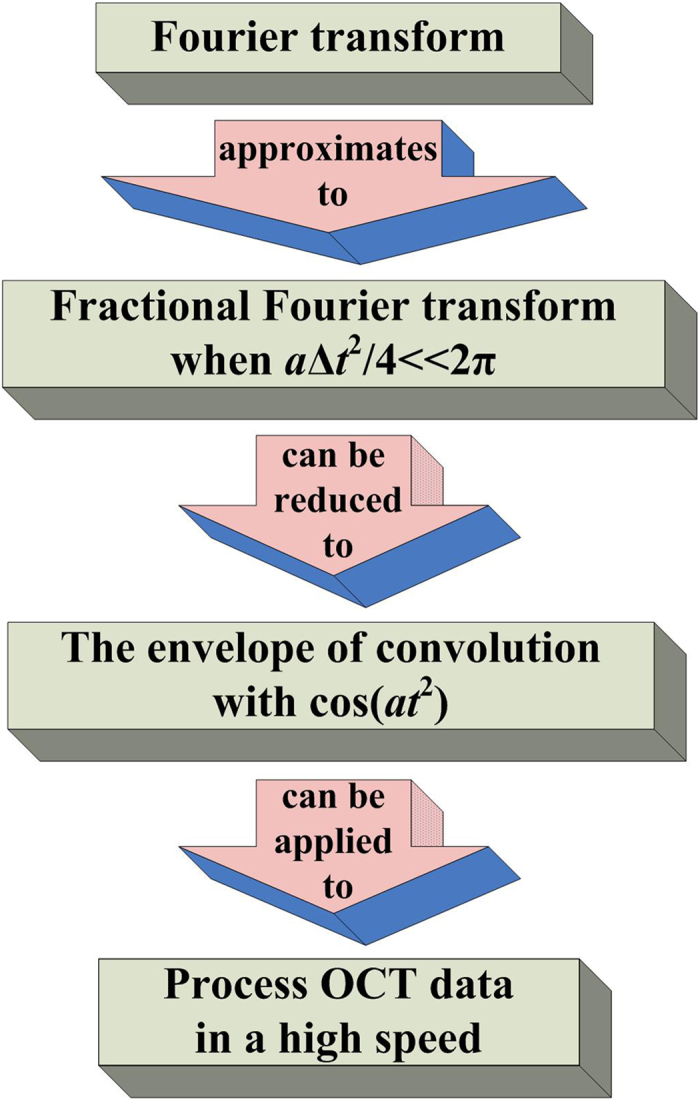
The fundamental principle of OC2T.